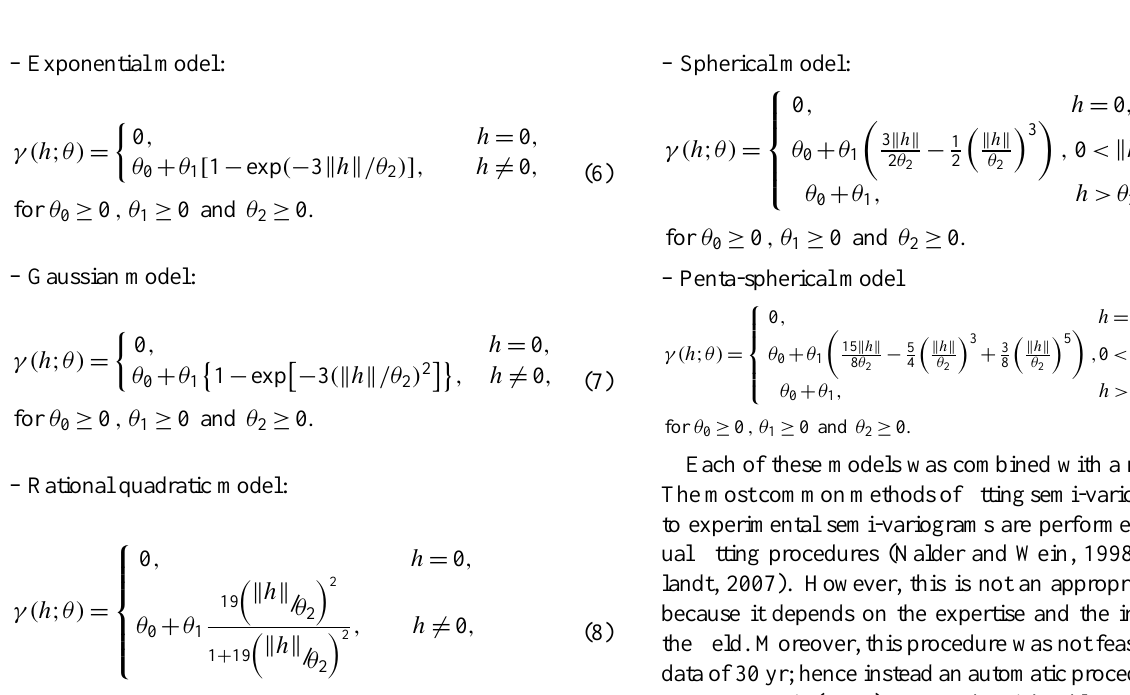
Fig. 1. Flowchart showing the simplified procedure of kriging computation. Cxx refers to weighted least squares criterion of each model fitting (see Eq. 11), Cxx +10000 refers added value to the criterion to avoid the variogram model from being used again when negative rainfall results